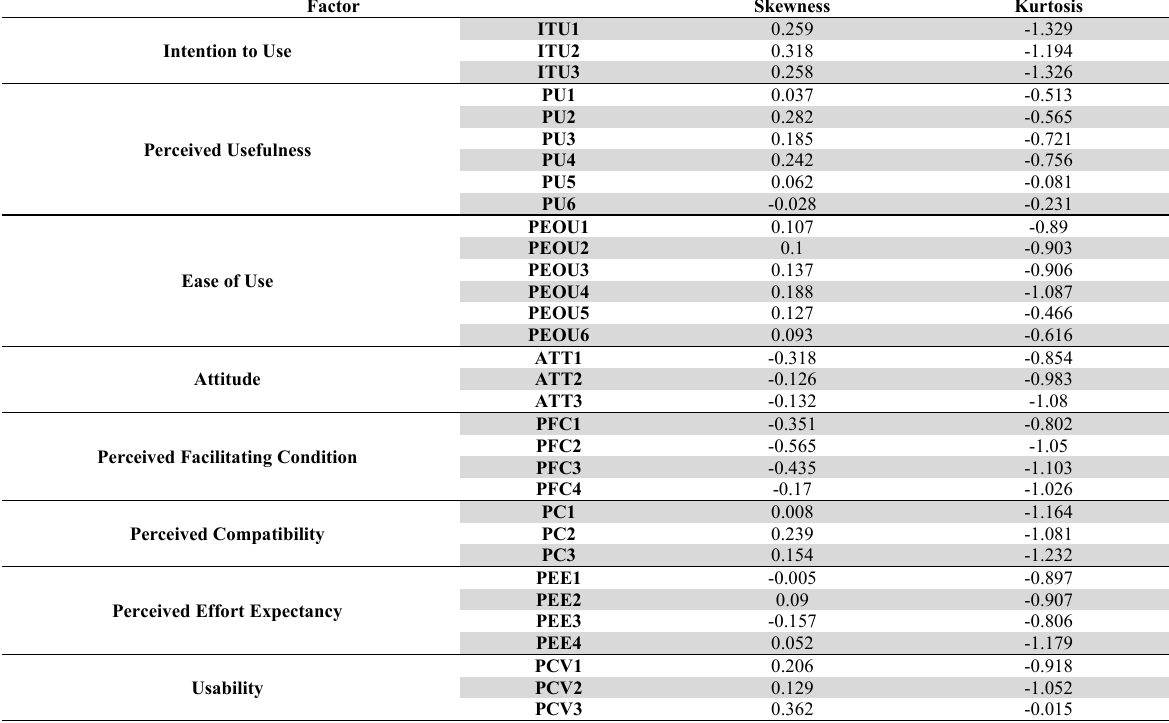
Normality of the Dataset